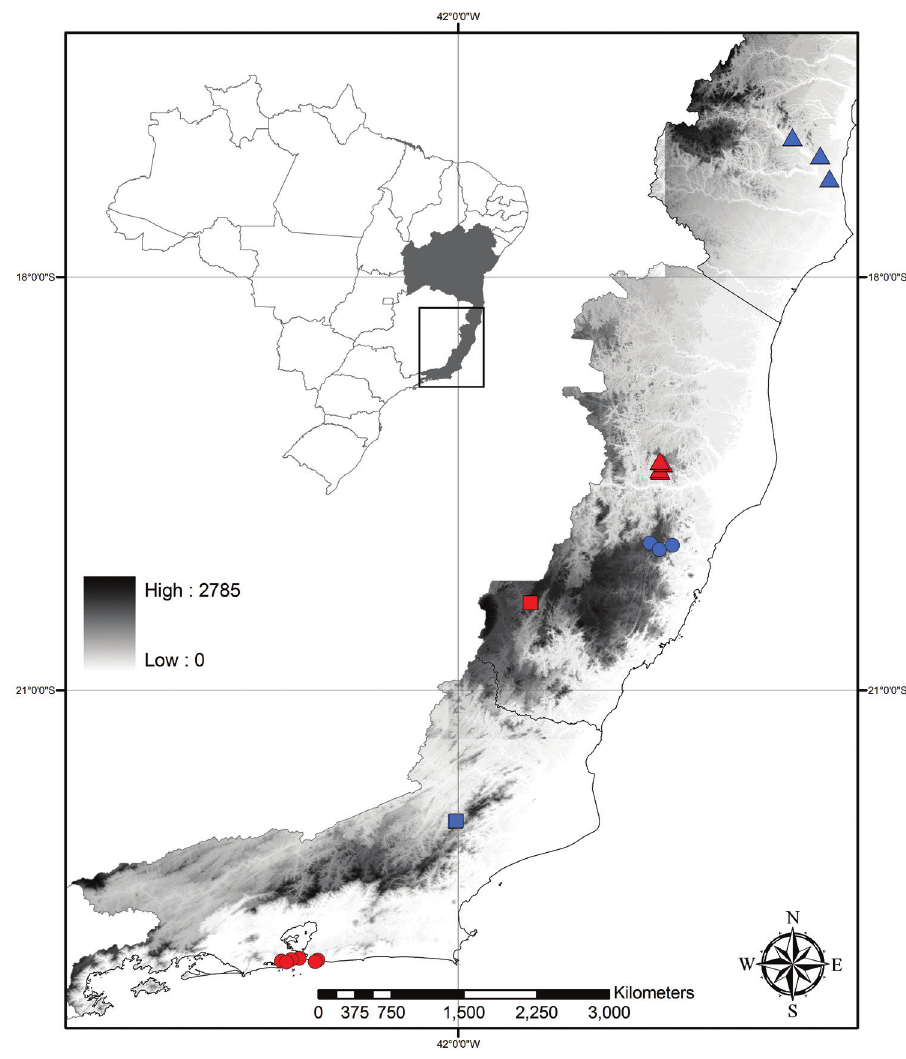
Figure 2. Distribution map of Siderasis Raf. emend. M.Pell. & Faden. Blue circles– S. albofasciata ; Blue triangles– S. almeidae ; Red circles– S. fuscata ; Red triangles– S. medusoides ; Blue square– S. spectabilis ; Red Square– S. zorzanellii ; BA– state of Bahia; ES– estate of Espírito Santo; RJ– estate of Rio de